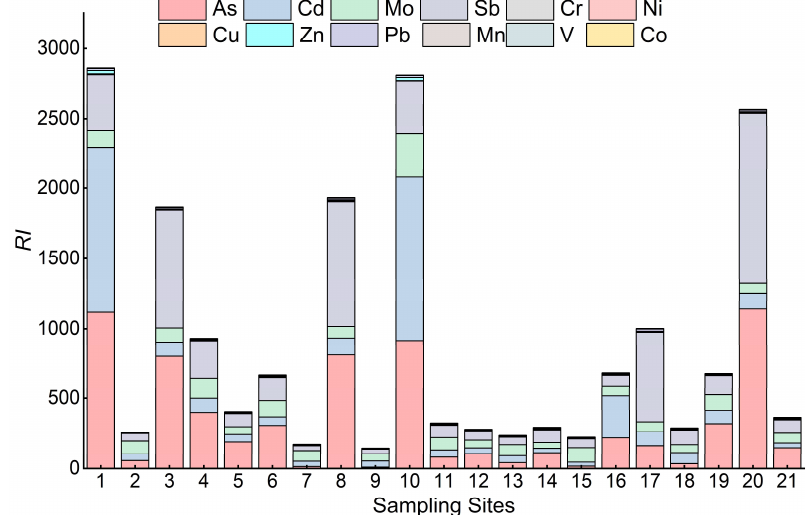
Figure 5. C omprehensive ecological risk index of each sampling sites. Figure 5. Comprehensive ecological risk index of each sampling